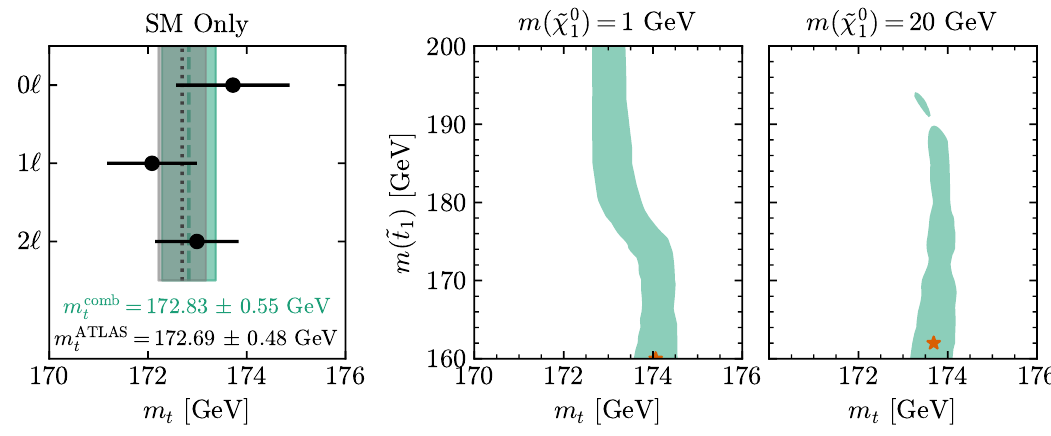
Figure 1 . Parameters which give the best (cid:12)t for the top mass measurement by ATLAS by com- bining the three di(cid:11)erent channels at p s = 8 TeV. The ATLAS measurements of the three di(cid:11)erent channels are shown in the left panel: all-hadronic [12] ( m t = 173 : 72 1 : 15 GeV), semi-leptonic [13] (cid:6) ( m t = 172 : 08 0 : 91 GeV), and di-leptonic [14] ( m t = 172 : 99 0 : 84 GeV). Assuming the SM only, (cid:6) (cid:6) the green band shows our crude best-(cid:12)t value of m comb with its associated uncertainty and the t (cid:0) (cid:1) black band shows the ATLAS combination m ATLAS given in ref. [13], taking into account 7 and t 8 TeV data. The center and right panels illustrate the impact of stealth stop contamination, where we show the best (cid:12)t point in the m t - m ( ~ t ) plane (marked by the orange star), and the 1- (cid:27) con(cid:12)- 1 dence interval as shaded bands. When the stops must decay through an o(cid:11)-shell top, they shift the reconstructed template mass extraction to values that are smaller than the actual top mass chosen in the Monte Carlo event